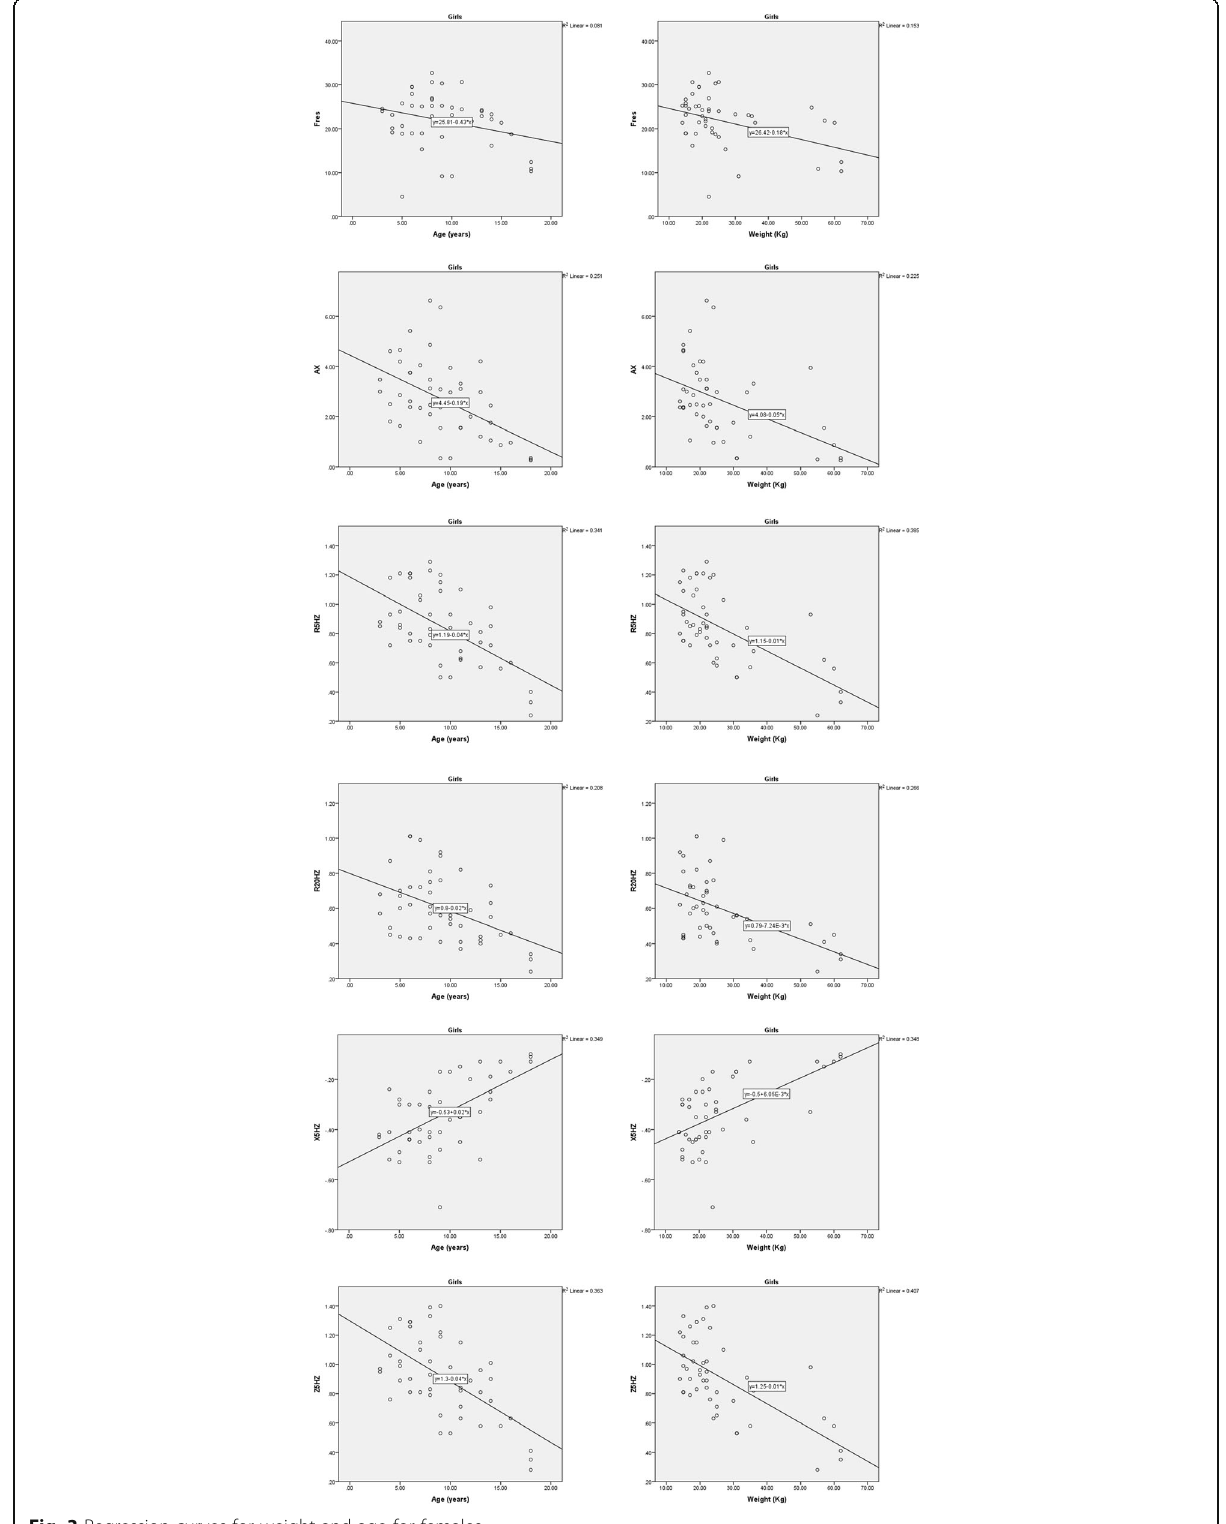
Fig. 3 Regression curves for weight and age for